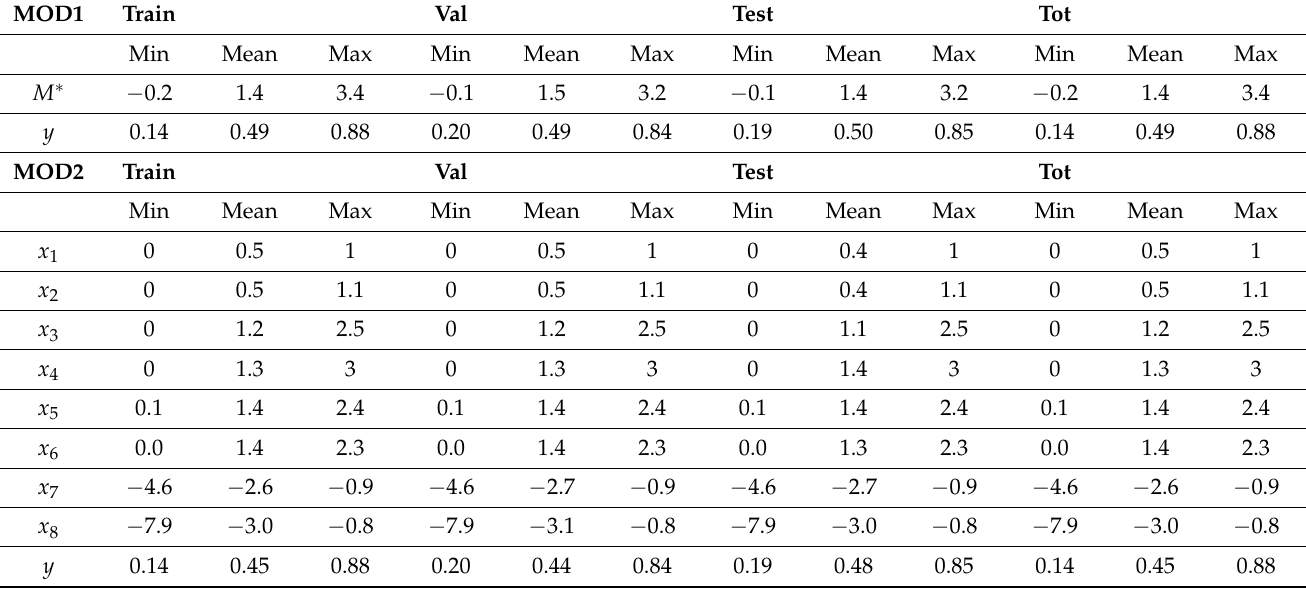
Table 2. Range of values for the total datasets used in MOD1 and MOD2 (using X =